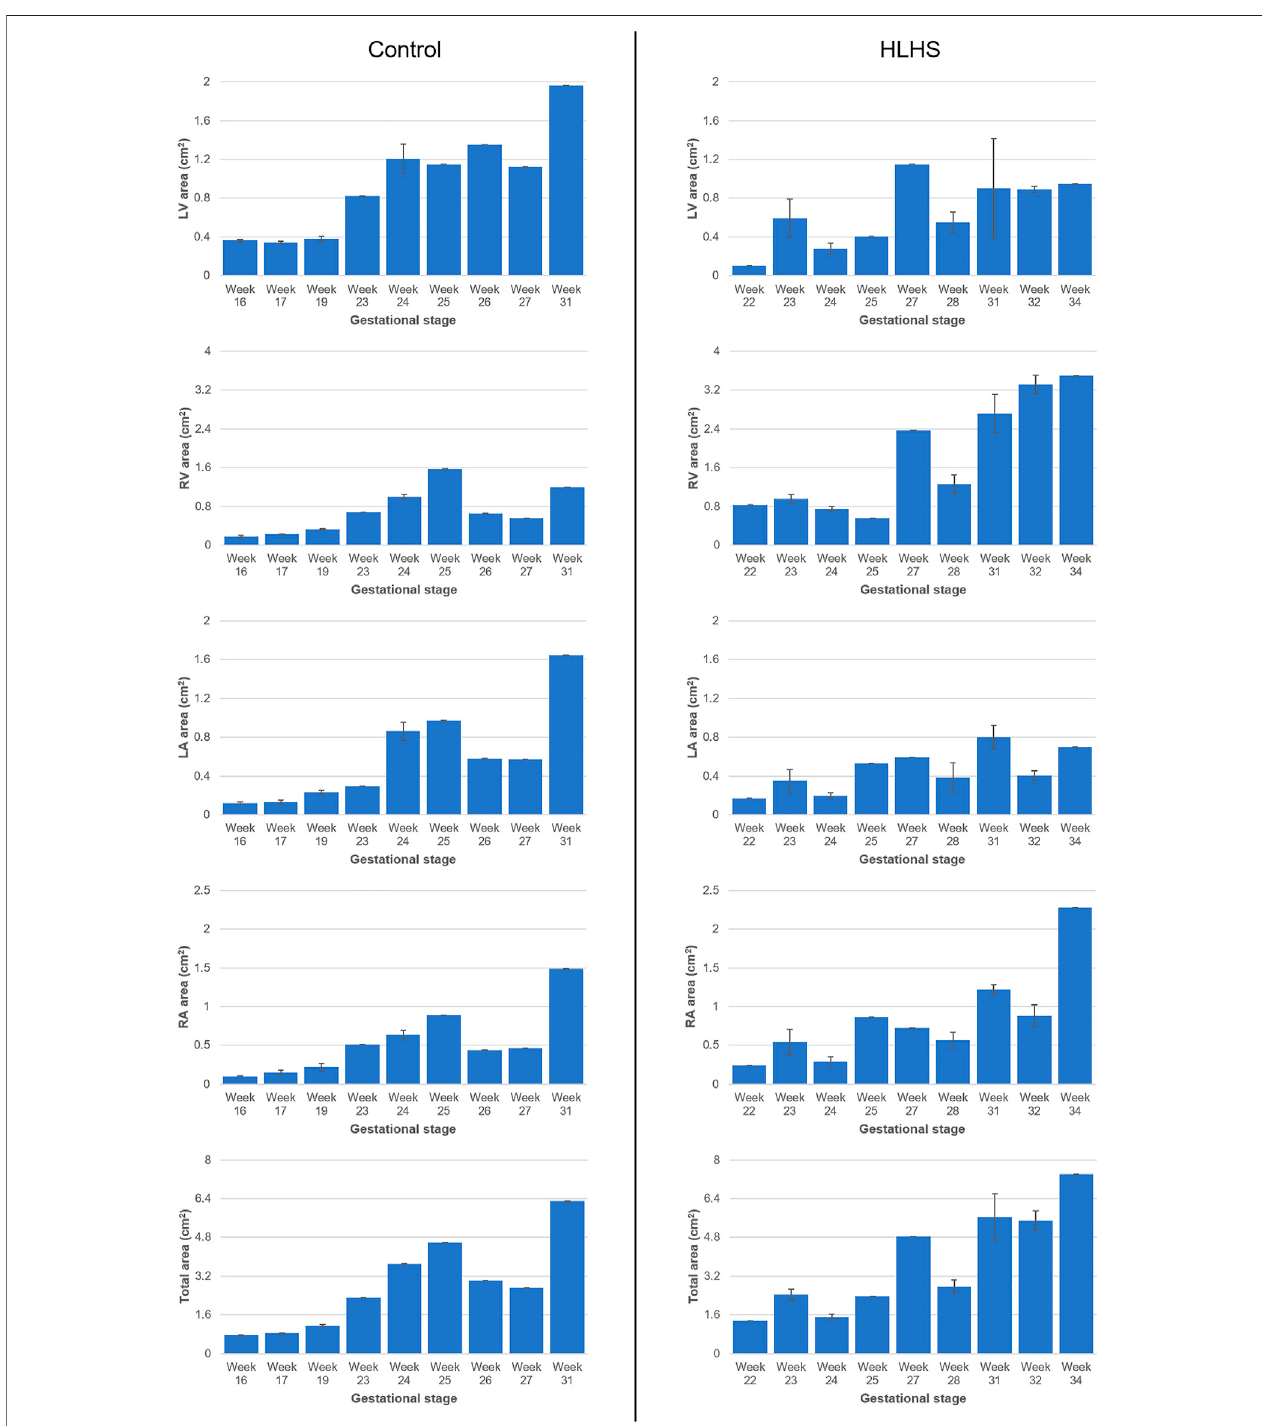
FIGURE 2 | Cross-sectional areas of the heart chambers for the control and HLHS hearts at various gestational stages.